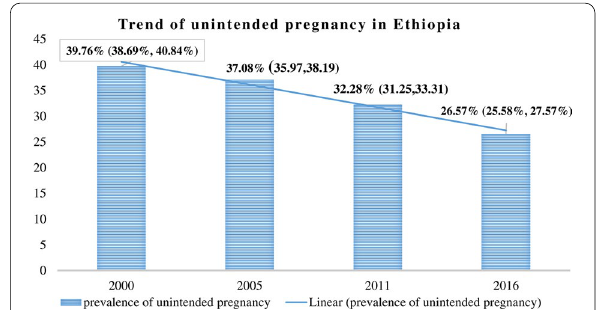
Fig. 1 Trends of unintended pregnancy among reproductive-age women in